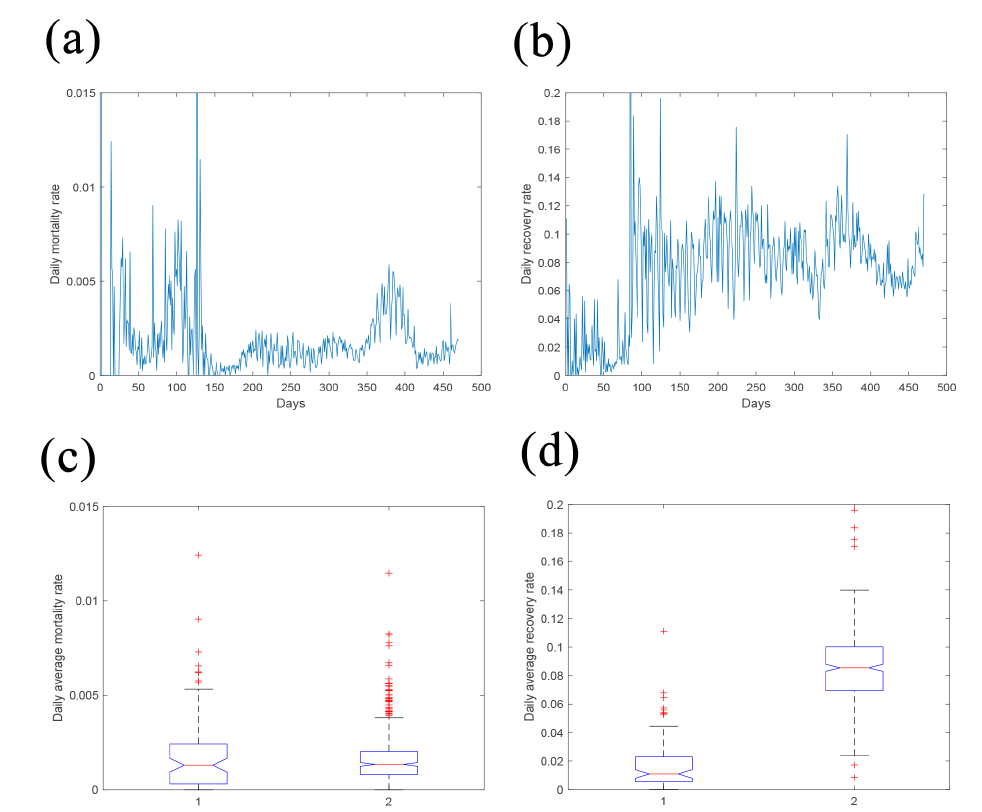
Figure 2. Determination of mortality and recovery rate. ( a ) Daily mortality rate; ( b ) Daily mortality rate; ( c ) Daily average mortality rate. ( d ) Daily average recovery rate. The first average mortality and recovery rate are statistically averaged over the period of stage 1, the second mortality rate is averaged over the period data of stage 2 and stage